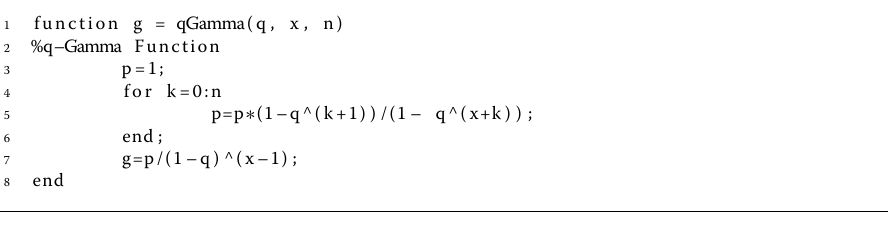
Algorithm 2 The proposed method for calculating (cid:12) q ( x )